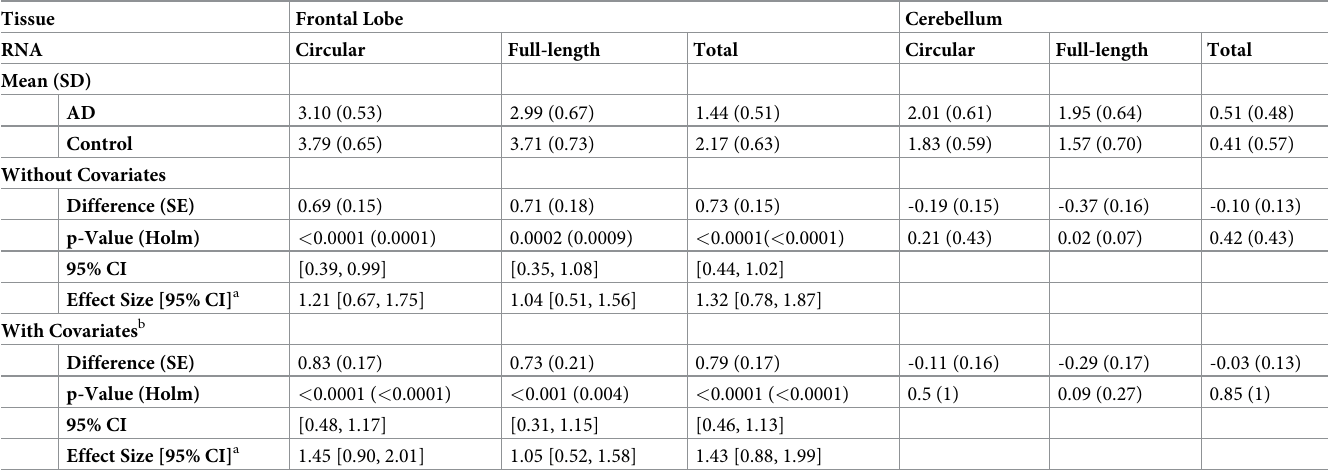
Table 2. Expression levels ( Δ Ct) of APOE RNA types in